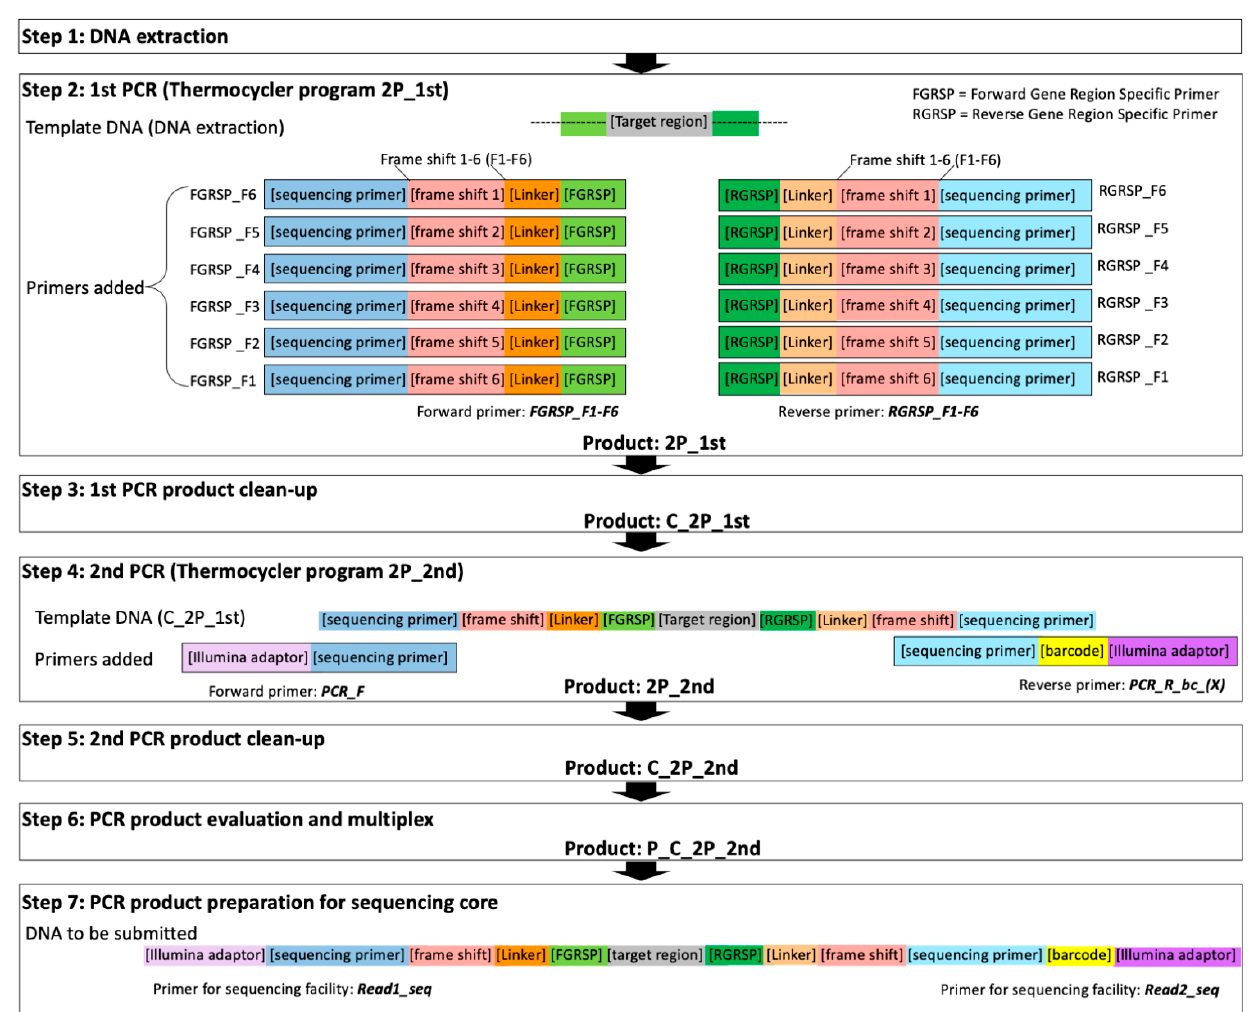
Figure 2. Schematic diagram of the workflow of two-step PCR protocol. The primers (forward: FGRSP_F1-F6, reverse: RGRSP_F1-F6) added in Step 2 include the “gene region-specific primer (GRSP)” (colored in green; e.g., ITS1F and ITS4); the “linker” region (orange), which contains two base pairs; the “frame shift” regions (pink), which are one to six randomized nucleotides (F1–F6); and the sequencing primers (blue) specific to the sequencing platform selected (e.g., Illumina). In Step 3, the forward primer (PCR_F) added includes sequencing primers and Illumina primers (purple). The reverse primer (PCR_R_bc_(X), X = barcode ID) has an additional 10 bp barcode region (yellow) that is used for the recognition of read originality. PCR product clean-up was carried out after each PCR reaction (Steps 3 and 5). The oligonucleotides and sequences of Read1_seq and Read2_seq are provided to the sequencing facility upon sample submission. Synthetic oligonucleotide sequences are provided in Supplementary Tables S1–S3. Thermocycler programs are illustrated in Figure 3.